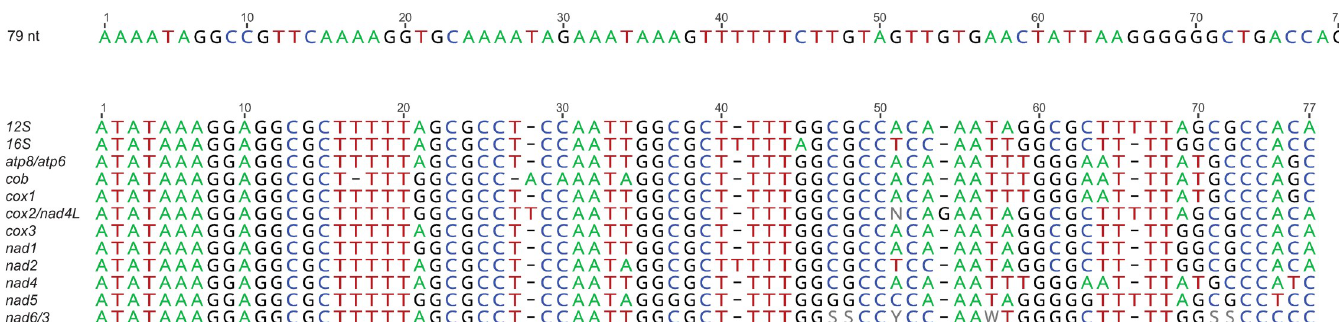
Fig 2. Sequence of the 79-nt sequence common to all Geomydoecus aurei mtDNA chromosomes and alignment of a 77-nt sequence that is found 108–205 nt downstream, which is referred to here as the “CSB” (Conserved Sequence Block). Some of these sequences were identified as having secondary structure similar to that of a tRNA gene in some analyses.